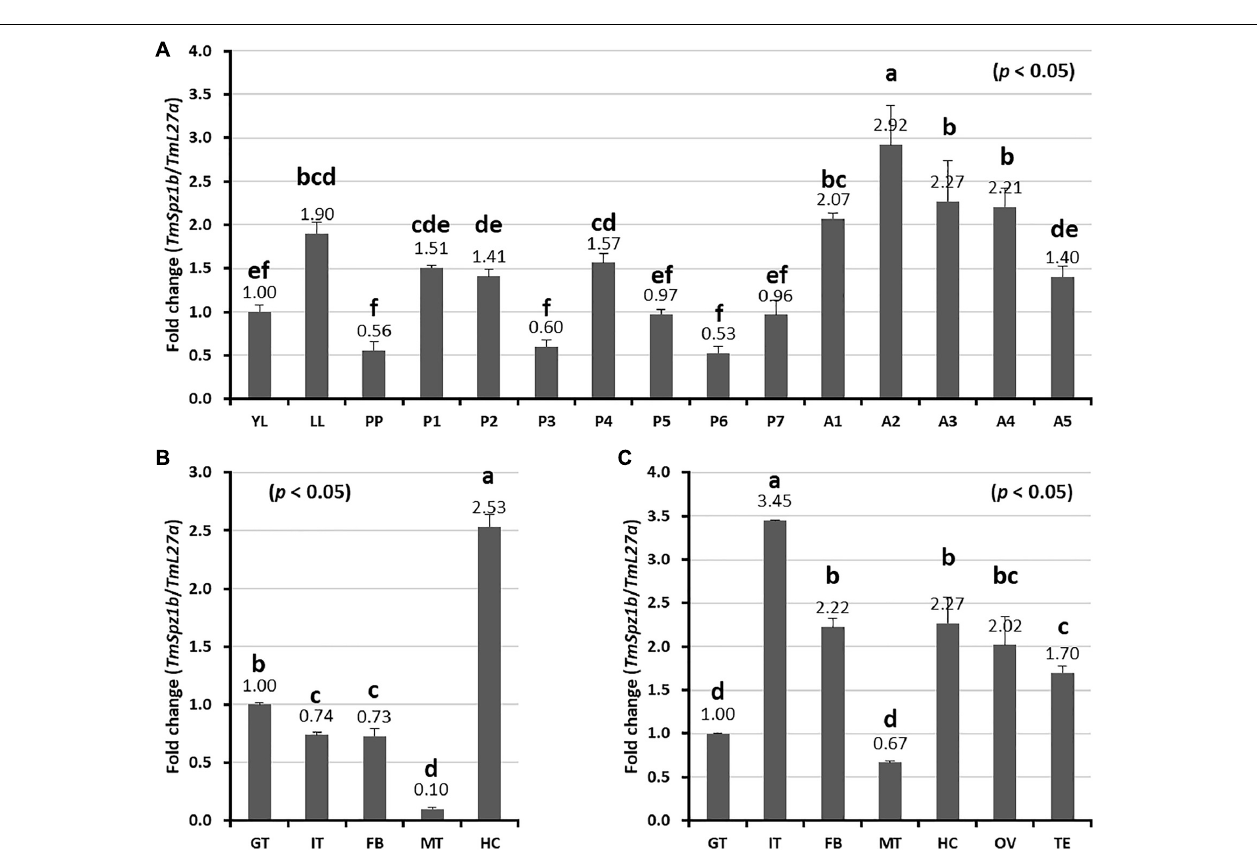
FIGURE 3 | Expression profiles of TmSpz1b mRNA during development and in tissues of T. molitor assessed by real-time PCR. (A) Developmental expression patterns of TmSpz1b mRNA. YL, young larvae (10th–12th instar); LL, late instar larvae; PP, pre-pupae; P1–P7, 1- to 7-day-old pupae; and A1–A5, 1- to 5-day-old adults. Tissue-specific expression profiles of TmSpz1b were examined in late instar larvae (B) and adults (C) . IT, integument; GT, gut; FB, fat body; HC, hemocytes; MT, Malpighian tubules; OV, ovary; and TS, testis. Total RNAs extracted from developmental stages and different tissues were reverse transcribed to cDNAs to serve as templates. Vertical bars represent mean ± standard error of three biological replicates. One-way ANOVA and Tukey’s multiple range tests at 95% confidence level ( p < 0.05) were performed and used to determine the level of significant differences. The graphs indicated by the same letter are not significantly different in Tukey’s multiple range test ( p <